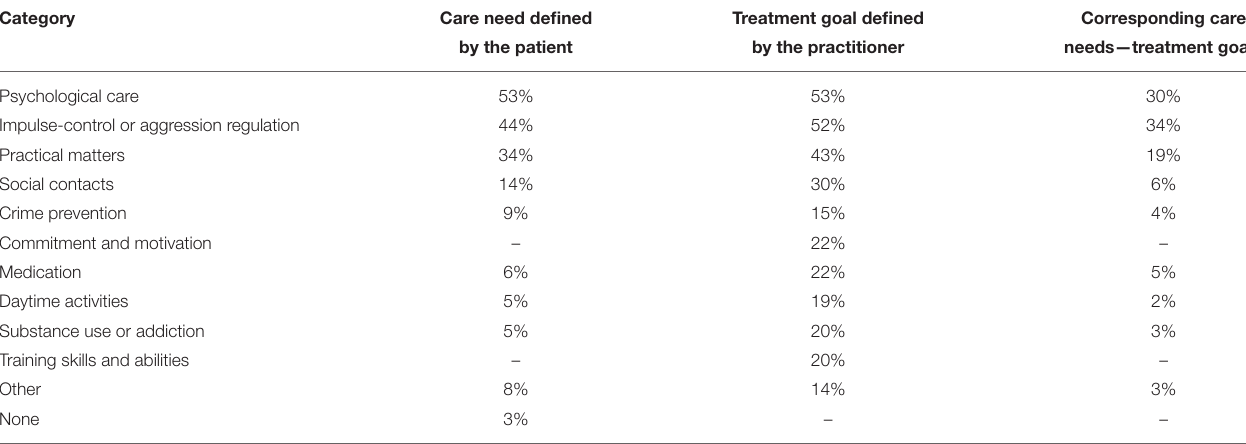
TABLE 1 | The self-expressed care needs of patients and treatment goals of practitioners at the beginning of treatment, divided into categories. Category Care need defined Treatment goal defined Corresponding care by the patient by the practitioner needs—treatment goals Psychological